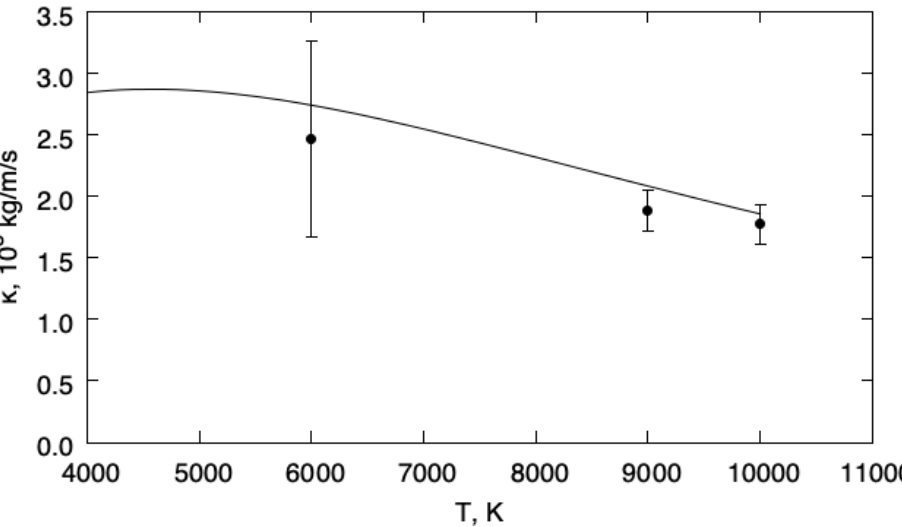
Figure 3. Bulk viscosities. Solid line: κ e ; symbols: